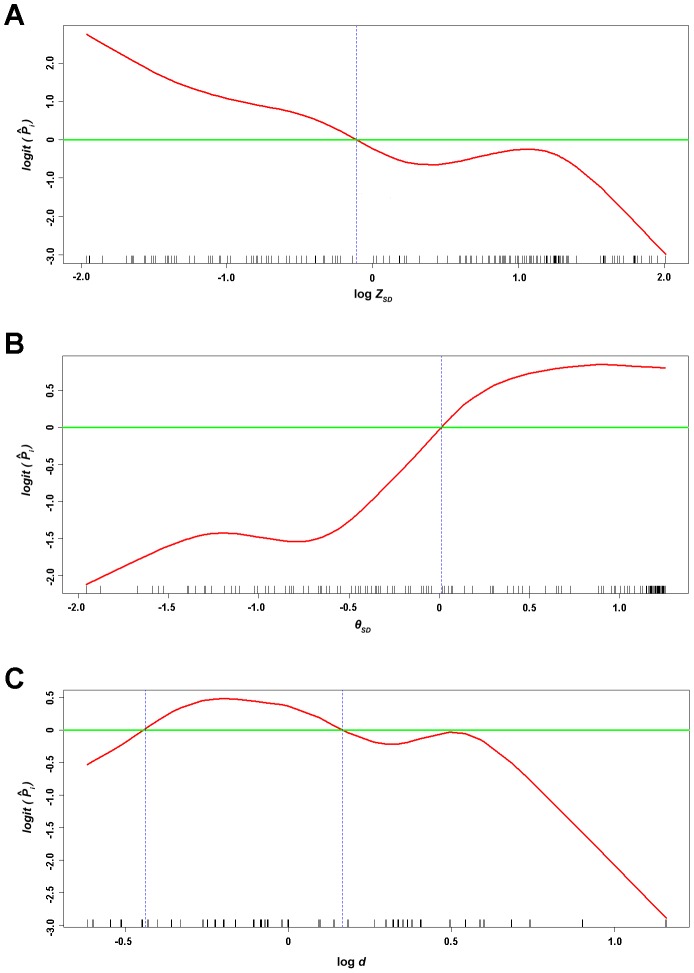
The GAM plots of the predictors, log ZSD (A), θSD (B), and log d (C) respectively.The generalized additive models plots reveal the smoothed partial effects of the predictors in modeling the probability of being verruca. The distribution of the observed values of log ZSD, θSD, and log d are shown by the rugs on the X-axes. The Y-axes are the logit of the estimated probability of being verruca (), i.e., log. The horizontal green line indicates the place where = 0.5.